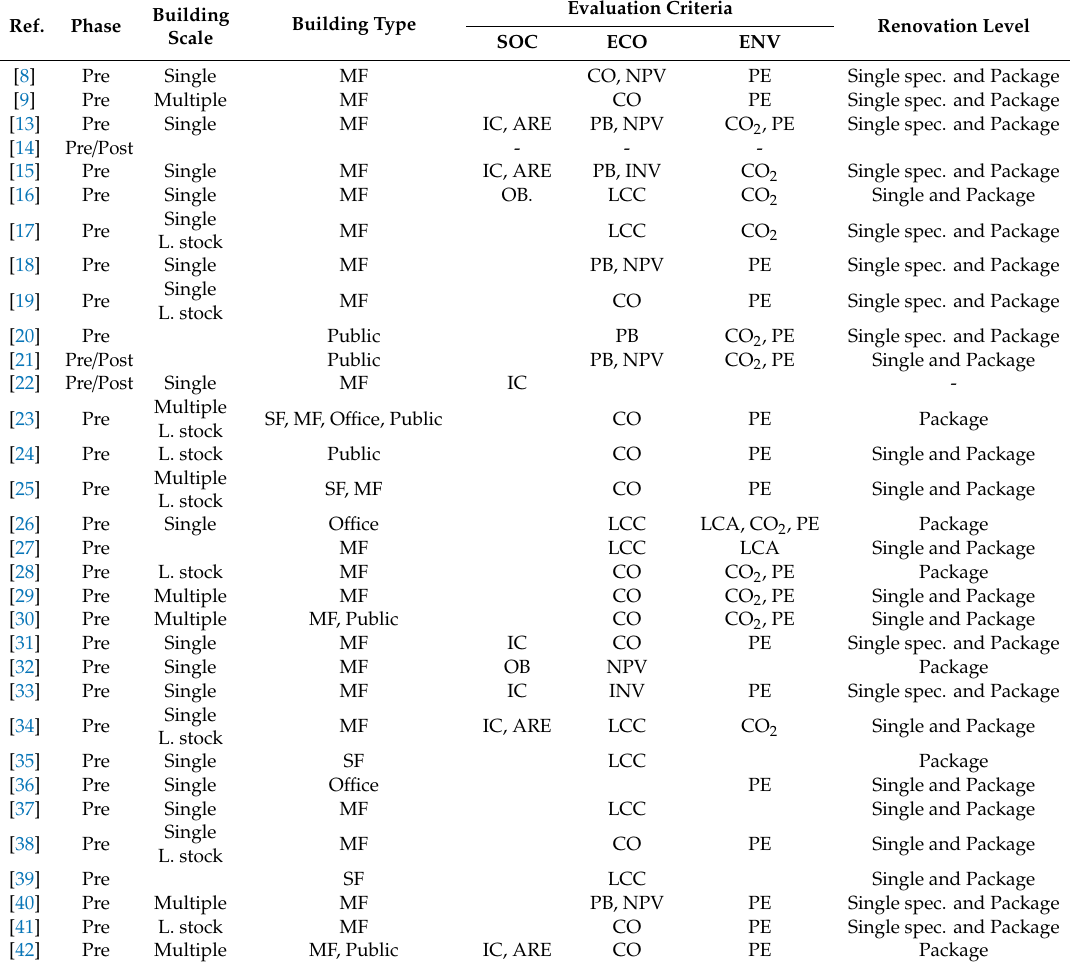
Table 1. Classification of applied renovation methodologies in accordance to evaluated criteria.